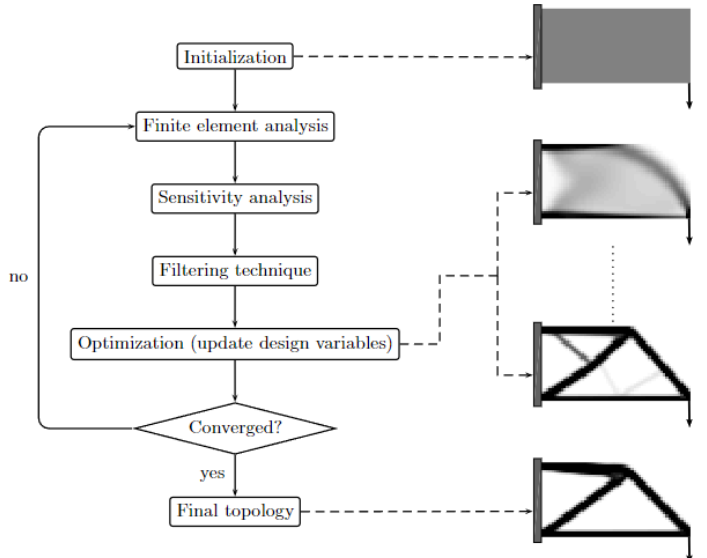
Figure 1. Schematic illustration of topology optimization steps [3].